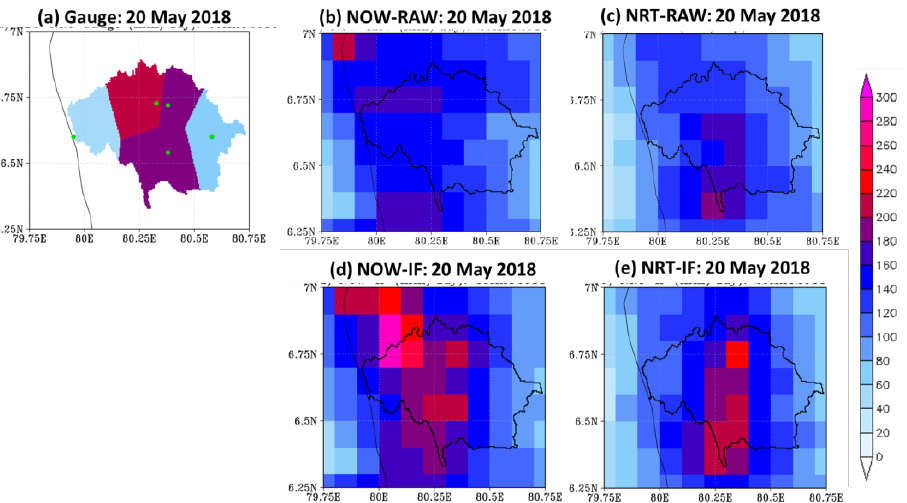
Figure 9. Comparison of daily cumulative rainfall (mm/day) distributions on 20 May 2018 for ( a ) real-time ground rainfall data; ( b ) GSMaP-NOW; ( c ) GSMaP-NRT; ( d ) bias-corrected GSMaP- NOW (NOW-IF); and ( e ) bias-corrected GSMaP-NRT